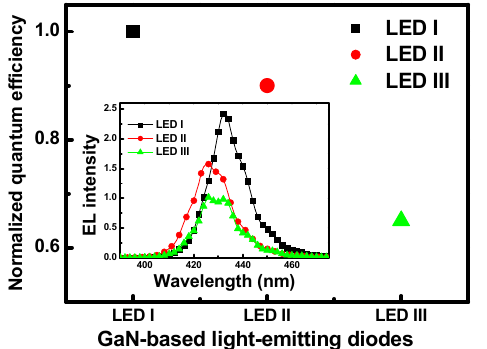
Figure 2. Normalized quantum efficiency for devices LED I, LED II, and LED III at room temperature and with a 20 mA injection current. The inset shows the EL spectra of samples LED I, LED II, and LED III at room temperature and with a 20 mA injection current.